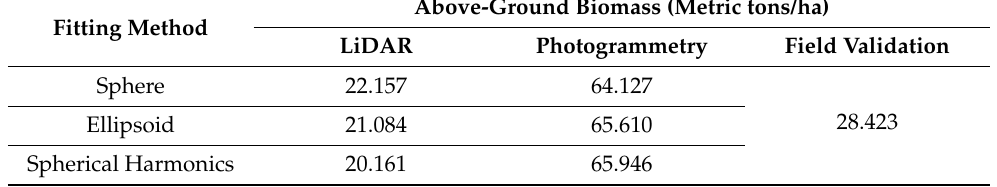
Table 4. The results of biomass calculations using the LiDAR method, photogrammetry, and conven- tional method. Fitting Method